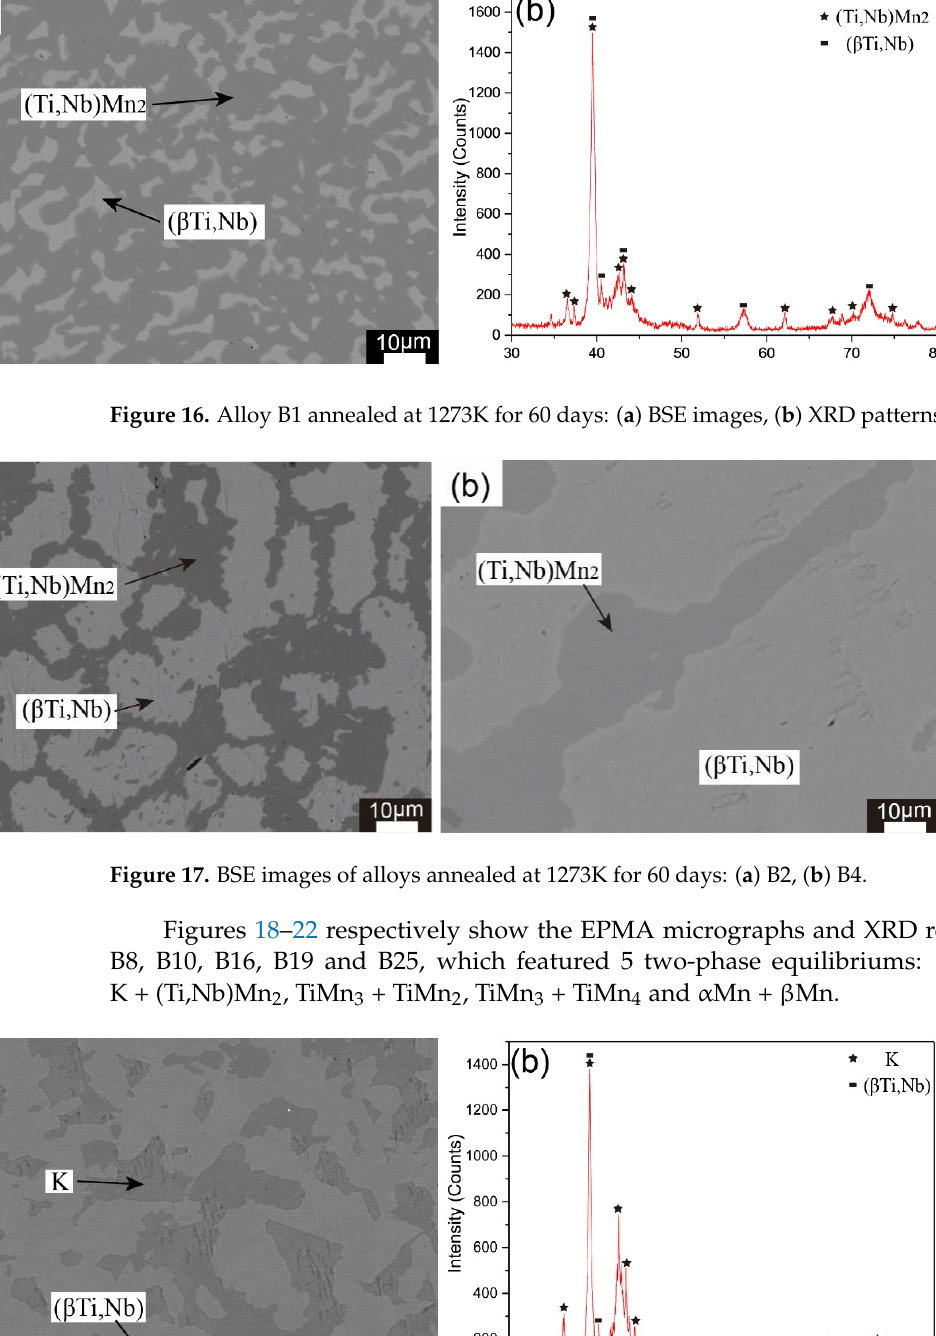
Figure 19. Alloy B10 annealed at 1273K for 60 days: ( a ) BSE images, ( b ) XRD patterns. Figure 20. Alloy B16 annealed at 1273K for 60 days: ( a ) BSE images, ( b ) XRD patterns.